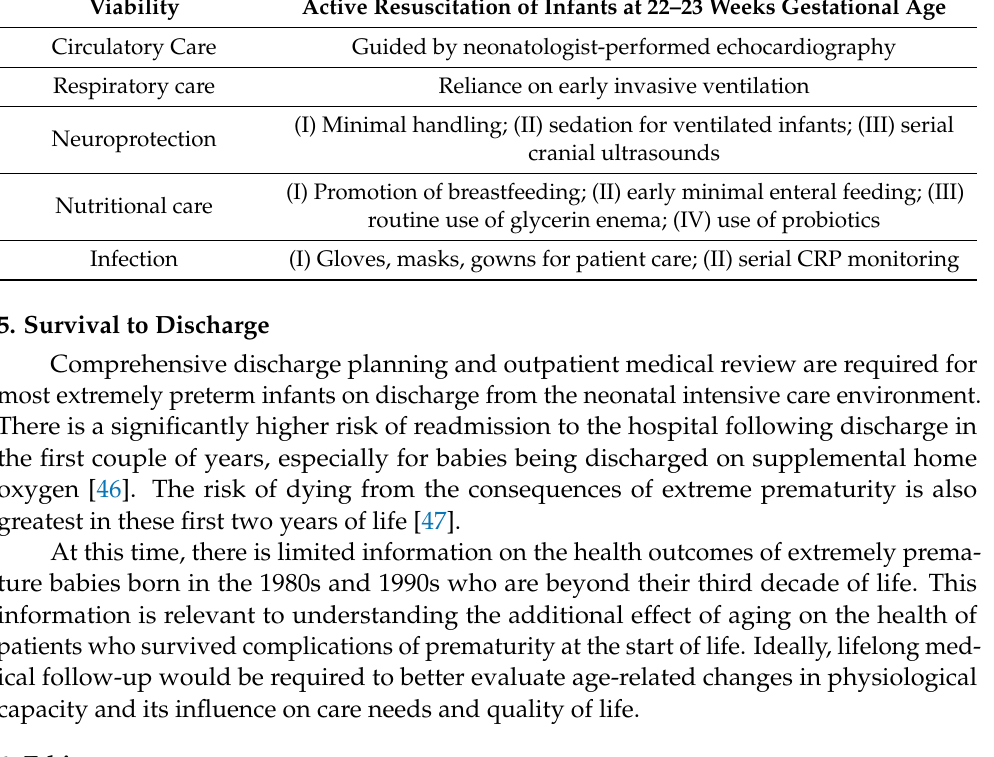
Table 1. Clinical approach to the management of extremely preterm infants in Japan. Viability Active Resuscitation of Infants at 22–23 Weeks Gestational Age Circulatory Care Guided by neonatologist-performed echocardiography Respiratory care Reliance on early invasive ventilation Neuroprotection cranial